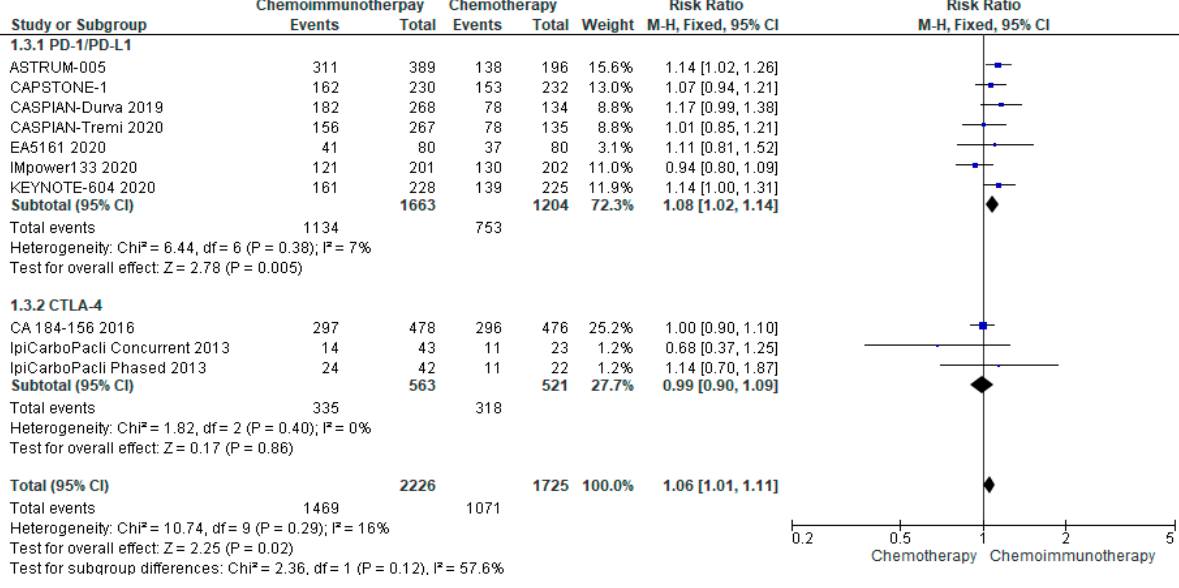
Figure 3. Forest Plot of risk ratios for ORR in patients with ES-SCLC and treated with chemo-ICI versus standard chemotherapy. PD–1/PD–L1, programmed death (ligand)–1; CTLA–4, cytotoxic T-lymphocyte-associated protein 4; HR, hazard ratio; CI, confidence interval; M-H,